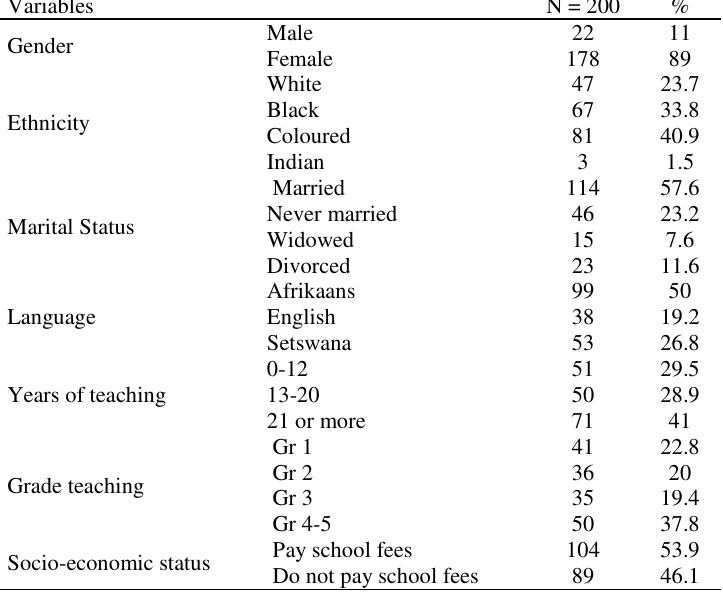
Table 1 Demographic information of primary school